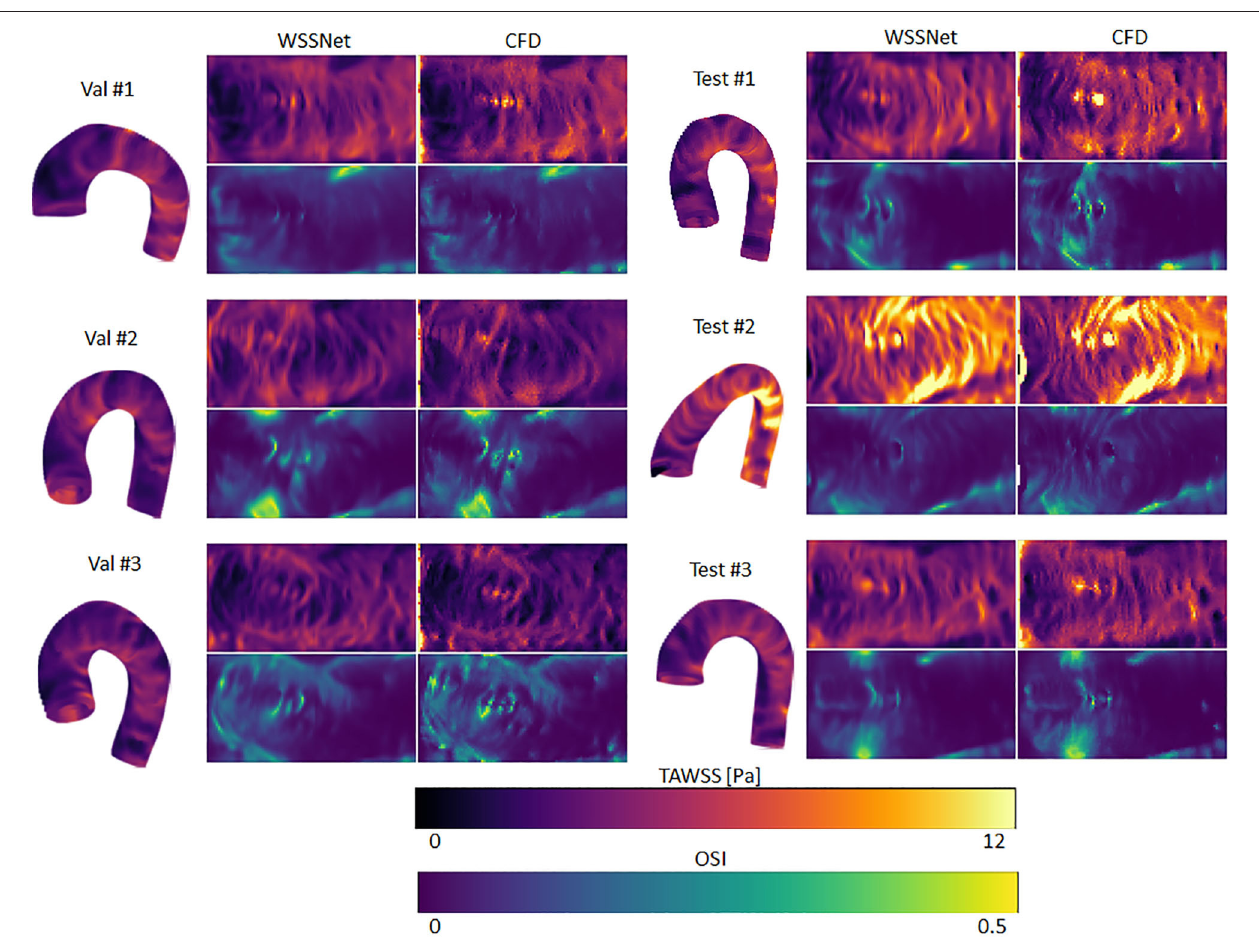
FIGURE 7 | Time-averaged WSS and oscillatory shear index (OSI) comparison between WSSNet and ground truth CFD. Time-averaged WSS (TAWSS) and OSI were calculated from all time frames (n = 72). 3D representations of the TAWSS from WSSNet are shown on the left side of each